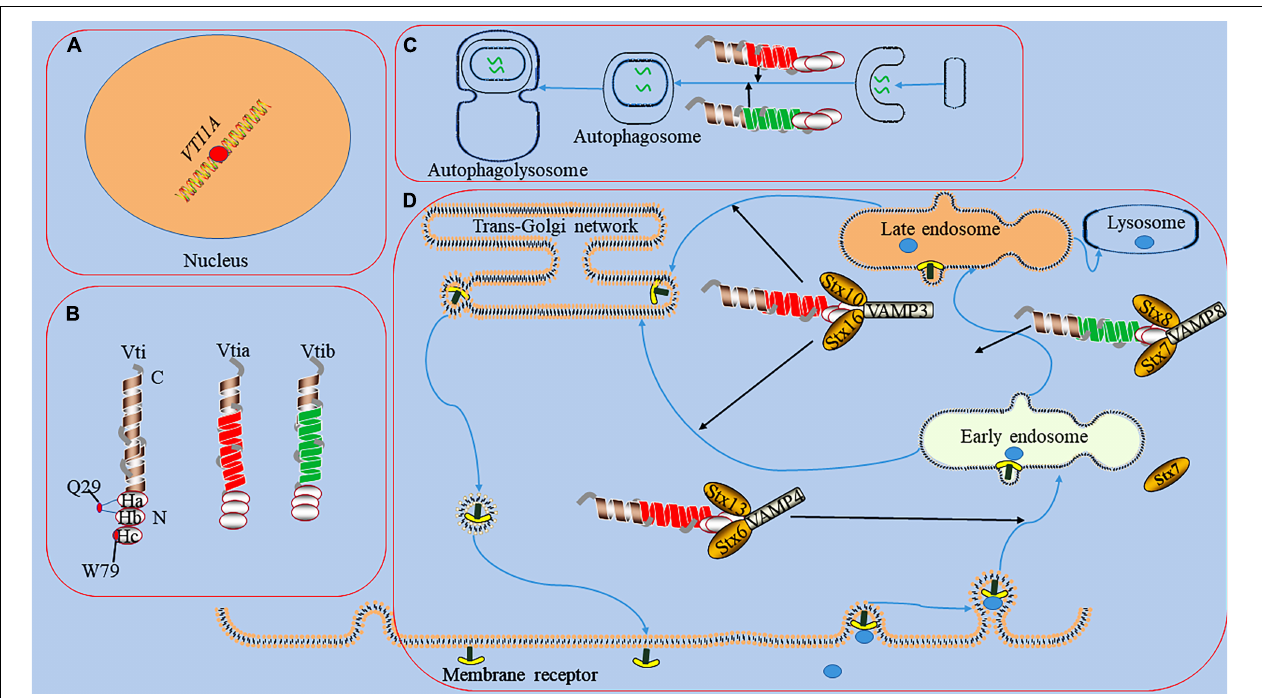
FIGURE 1 | The functions of Vti1a in endosomal circulation and the formation of autophagosome. panel (A) , it represents the dot of VTI1A on Mutations/variations; the mutations/variations and gene fusions of VTI1A (red dots) in glial cells may be oncogenic. Panel (B) , it shows the domains and structures of Vti1a and Vti1b, a Vti protein contains a C-terminal transmembrane domain, a Qb-SNARE motif, and an N-terminal Habc domain; the Habc domain exists 2 mutants (Q29R localized in the loop between Ha and Hb and W79R localized on Hc); there has a low sequence homology between Vti1a and Vti1b. Panel (C) , it displays the process of the formation of autophagosome; Vti1a and Vti1b mediates autophagosome maturation. Panel (D) , it reveals endosomal circulation; Vti1a forms a SNARE complex with Syntaxin (Stx)10, Stx16, and VAMP3 to mediate the transport of related substances from the endosome to the Golgi apparatus. Vti1a co-immunoprecipitates with VAMP4, Stx6, and Stx16 in early circulating endosomal transport. Vti1b forms a complex with Stx7, Stx8, and VAMP8 and plays a role in late endosomal